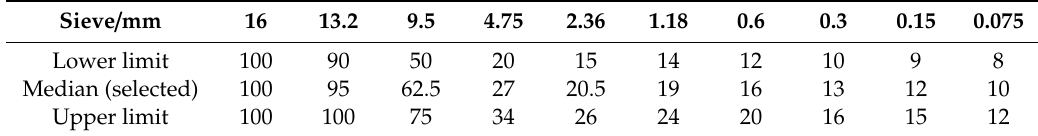
Figure 1. Gradation curve of SMA-13. Table 6. Aggregate gradation of SMA-13.